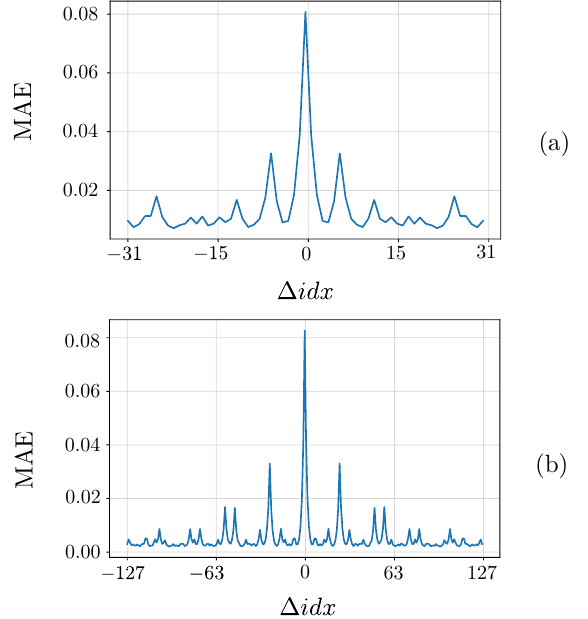
Figure 4. MAE for different seed indexes measured from a 6-bit LFSR ( a ) and an 8-bit LFSR ( b ) for the stochastic multiplication. LFSR polynomials are shown in Appendix A Table